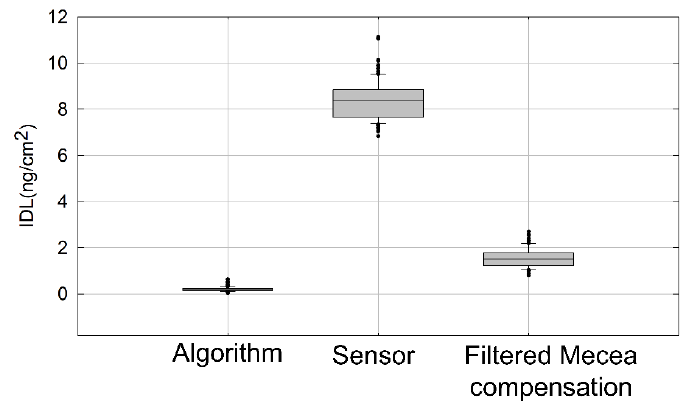
Figure 4. Instrument detection limit (IDL) calculated from raw sensor data, the filtered Mecea compensation method and the algorithm presented in this paper. IDL has been calculated as 3σ/S in ng/cm 2 , where σ is the system noise in Hz, and S is the sensitivity in Hz cm 2 /ng. A total of 100 intervals of the acquired baseline have been used in the calculation. Error bars are included in the figure.